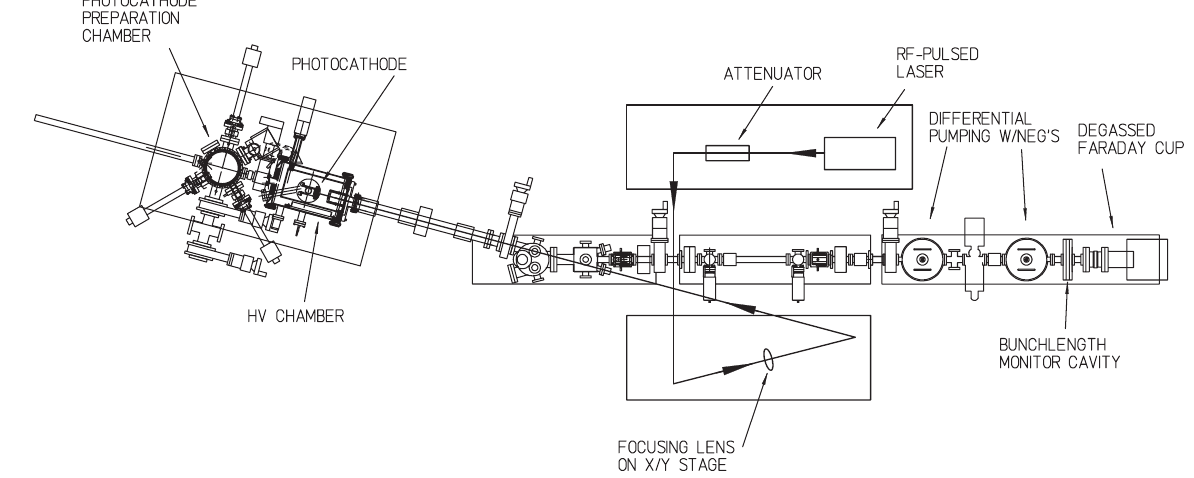
FIG. 3. The DC high voltage load-locked GaAs photogun and diagnostic beam line. The cavity bunch-length monitor was positioned near the beam dump. Besides the labeled components, the beam line consisted of valves, vacuum pumps, view screens, beam position monitors, a wire scanner, steering and focusing